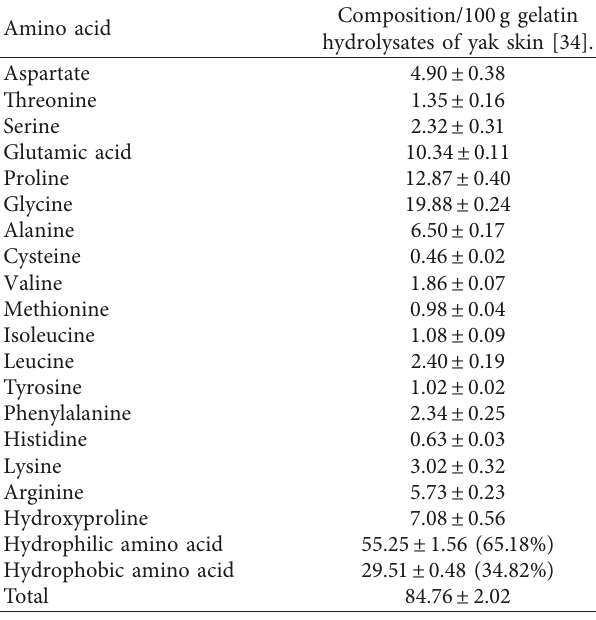
Composition/100 g gelatin